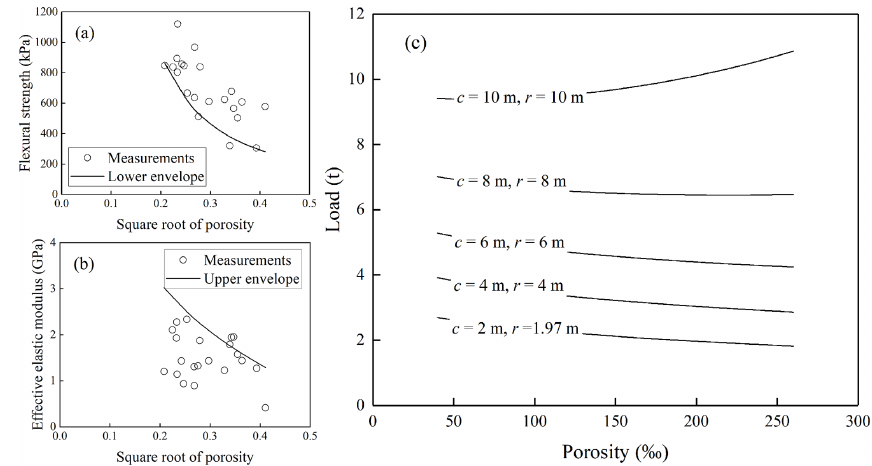
Figure 15. Variations of load with respect to sea ice porosity for a landfast sea ice with congelation ice thickness of 1.3m. c and r are radius of loaded area and effective beam length,